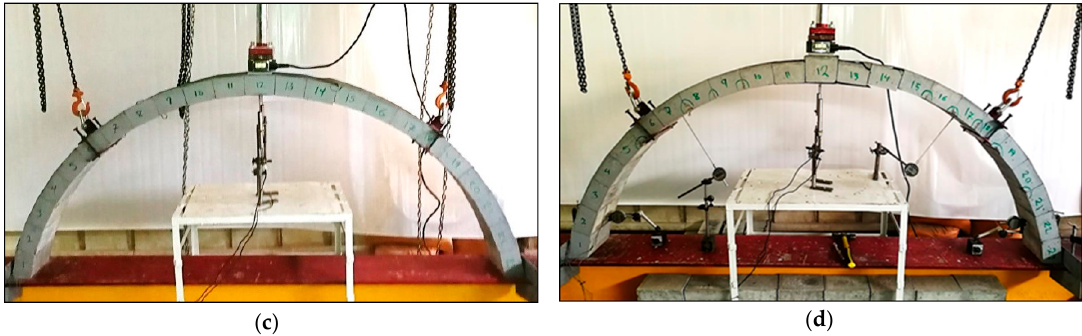
Figure 16. Failure of tested self-form masonry arch: ( a ) F1-80-80-NS, ( b ) F3-80-100-NS, ( c ) Figure 2, and ( d ) F4-80-100-ST.